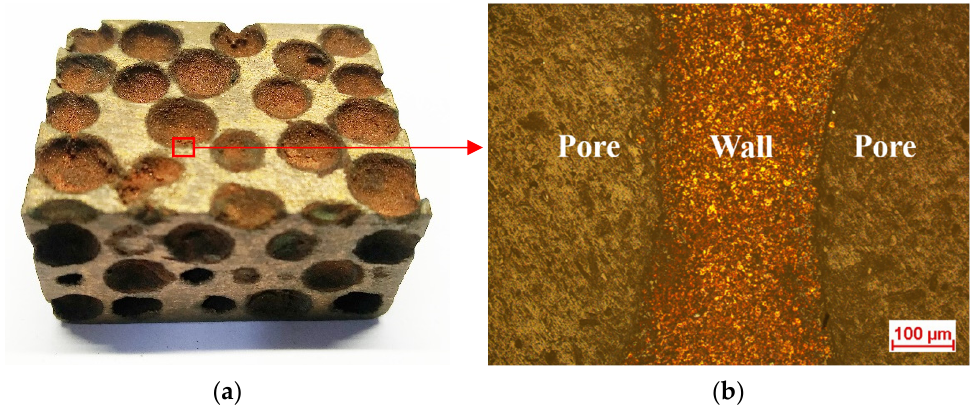
Figure 4. Microphotograph of the pore wall: ( a ) produced CCCF sample; ( b ) cell structure schematic diagram of CCCF sample.